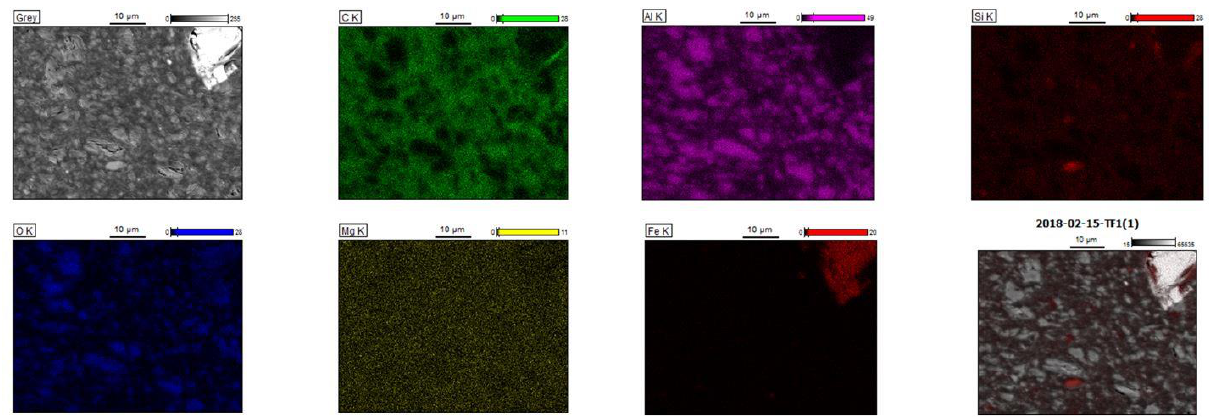
Figure 4. SEM/EDS base image and elemental mapping for C, carbon; Al, aluminum; Si, silica; O, oxygen; Mg, magnesium; and Fe, ferrite of the hybrid nanocomposite containing 12% (2:1) HNTs and ATH-sil.